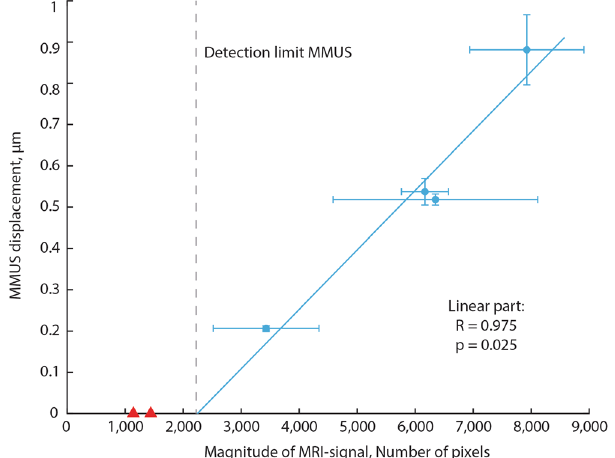
Figure 5. The solid line is a linear regression analysis of the relationship between the MMUS and MRI signals for the four rats with detectable MMUS signal. Correlation of the observations is evaluated using least squares regression analysis with calculation of Pearson’s product moment correlation coefficient, R statistics = 0.975 and p = 0.025. The error bars show the standard deviations of the mean for three observers, i.e. three mean values for each animal (each of these mean values are calculated from the 18 cross sections). The measurement values are displayed as asterisks ( * ). The two rats where no MMUS signal was found, are displayed as triangles ( Δ ) in the graph. An indication of the existence of a MMUS detection limit is presented as a dashed line in the